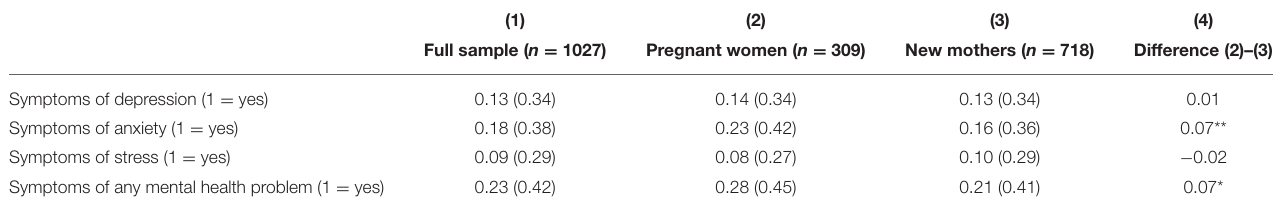
TABLE 3 | Prevalence of depression, anxiety and stress symptoms among full sample and